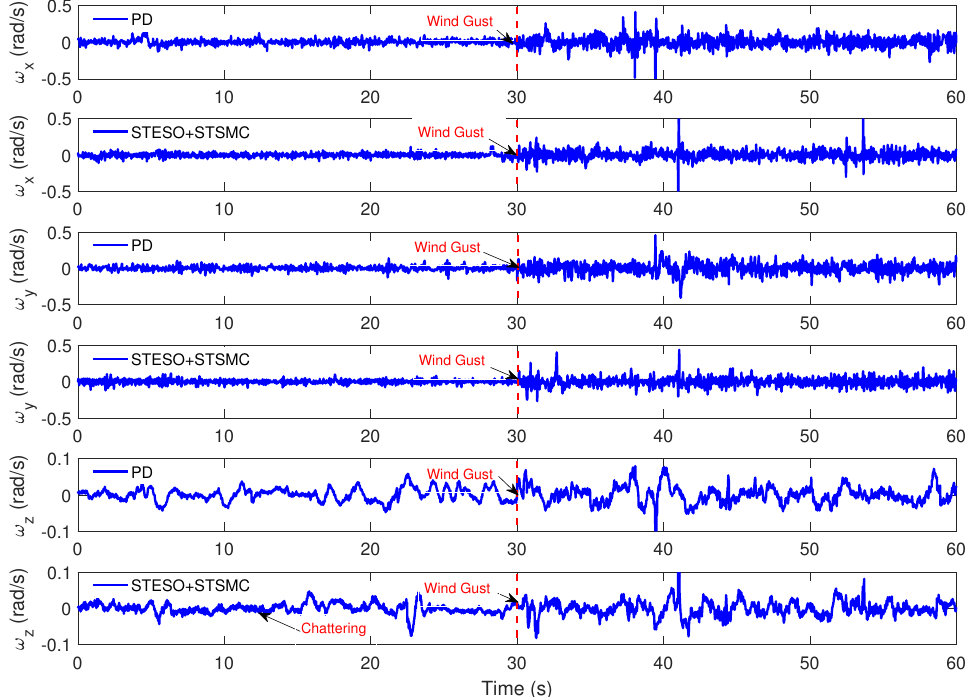
Figure 16. Experimental curves of angular rates ω x , ω y , ω z in Case B.